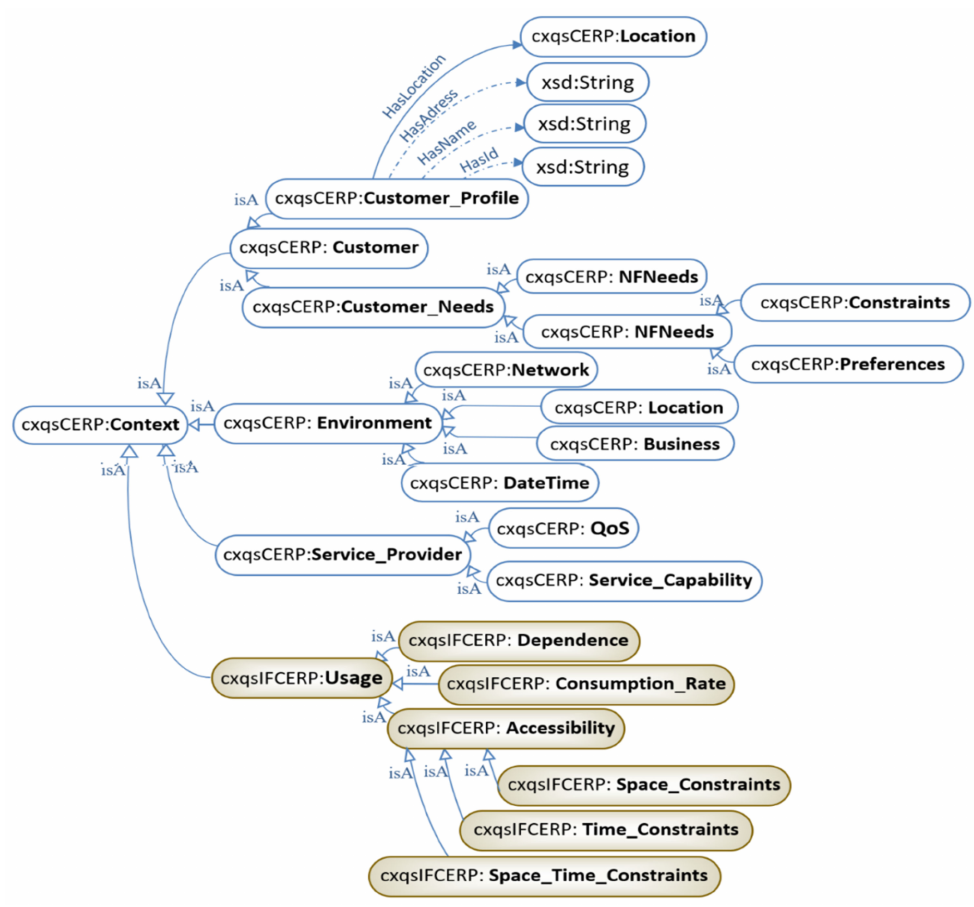
Figure 8. Usage context for smart and Cloud